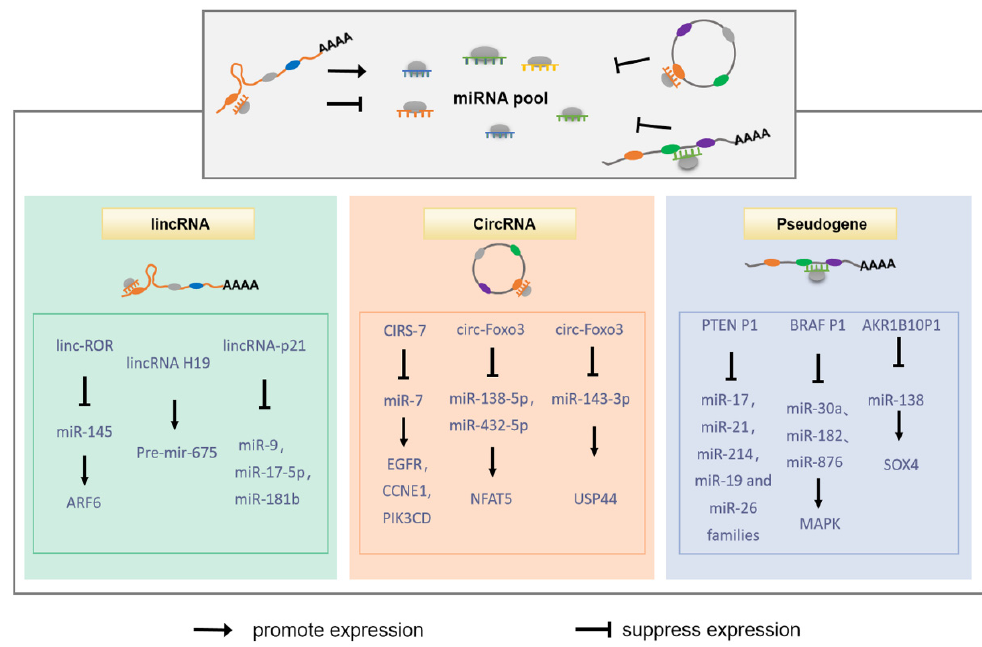
Figure 5. Regulation of miRNA by LncRNAs. LincRNAs, circRNAs, and pseudogenes can act as “sponges” of miRNA through the ceRNA mechanism, thereby participating in the regulation of specific miRNA targeting mRNA in different tumor